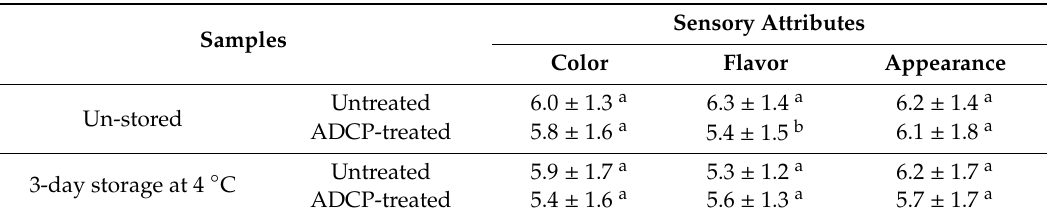
Table 7. E ff ects of atmospheric dielectric barrier discharge cold plasma (ADCP) treatment on the sensory attributes of chicken breast cubes with 3-day storage at 4 ◦